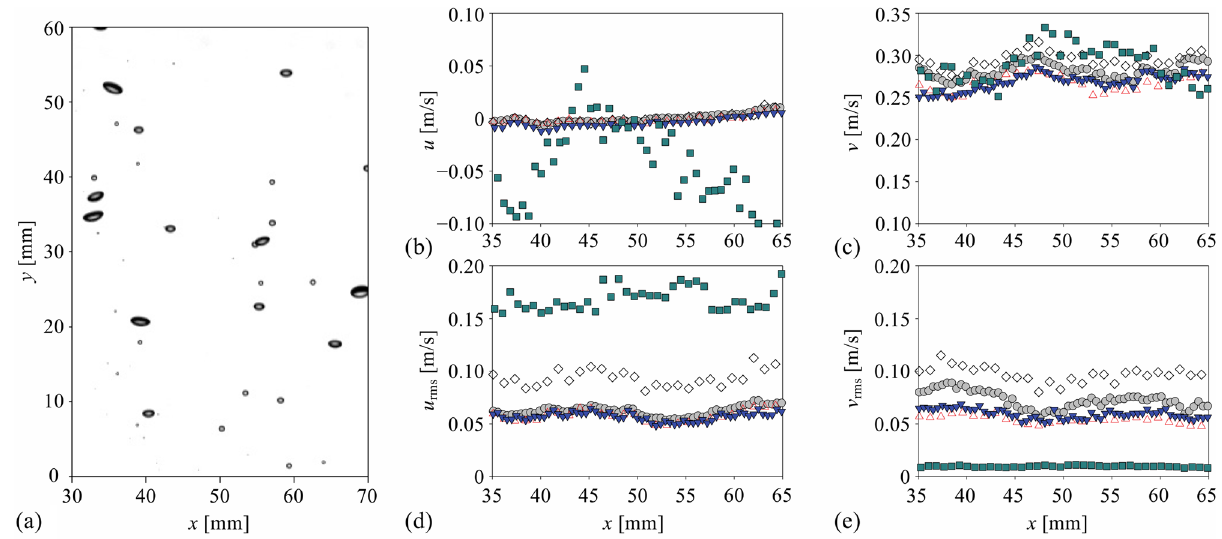
Figure 7. Evaluation of the bubble velocity in the dilute bubble plume (1.13% void fraction): ( a ) instantaneous image of the dilute bubble plume; ( b ) horizontal velocity; ( c ) vertical velocity; ( d ) horizontal root-mean-square (r.m.s.) velocity; ( e ) vertical r.m.s. velocity. All velocity components were averaged in time and y -direction. filled circle, PTV; open triangle, Lukas-Kanade; open diamond, Farnebäck; filled square, pre-trained CNN-based model; inverted filled triangle, fine-tuned CNN-based